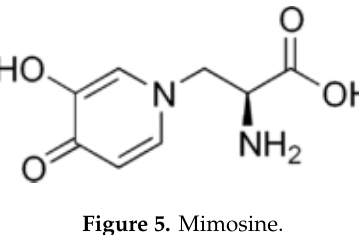
Figure 5. Mimosine. Figure 5.